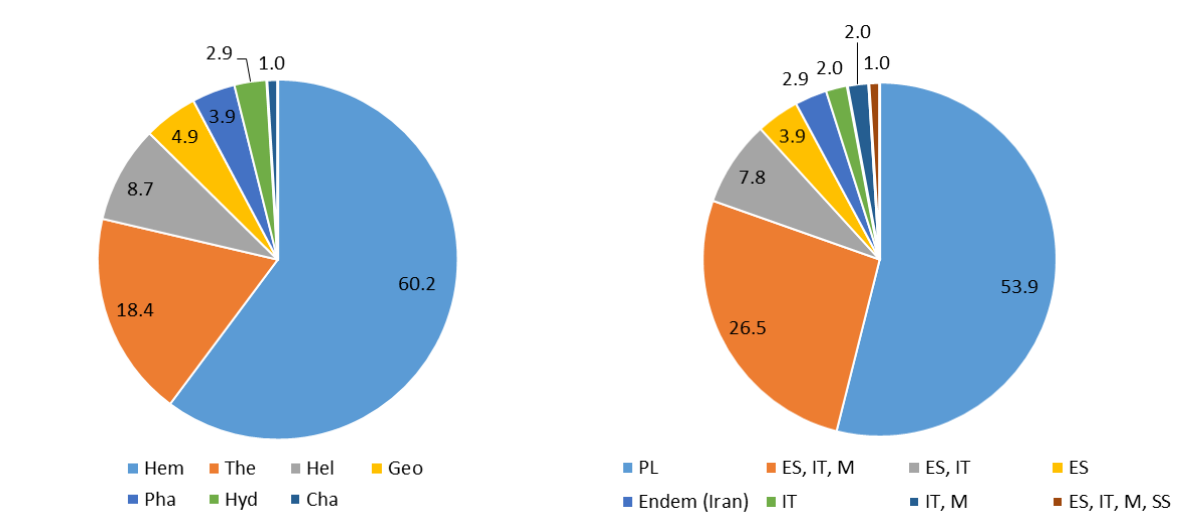
Figure 2. The life form (left) and chorotype spectrum (right) of the plant species in Chaman-e Kelar Mire. Life forms: Cha = chamaephyte; Geo = geophyte; Hel = helophyte; Hem = hemicryptophyte; Hyd = hydrophyte; Pha = phanerophyte; The = therophyte. Chorotypes: ES = Euro-Siberian; IT = Irano- Turanian; M = Mediterranean; PL = pluriregional; SS = Saharo-Sindian. Endem =